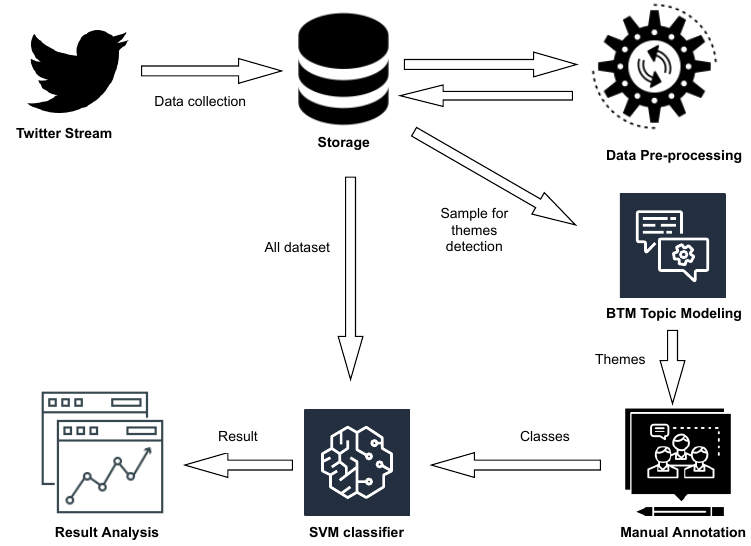
Figure 1. The workflow of the proposed